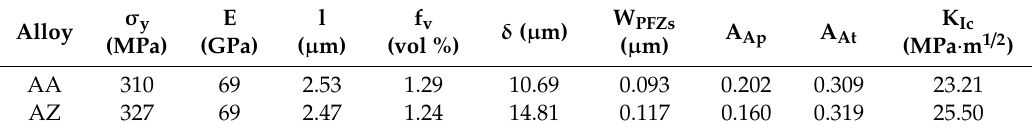
Table 10. Values of parameters of Equation (5) and KIc of alloys AA and AZ at peak aged state